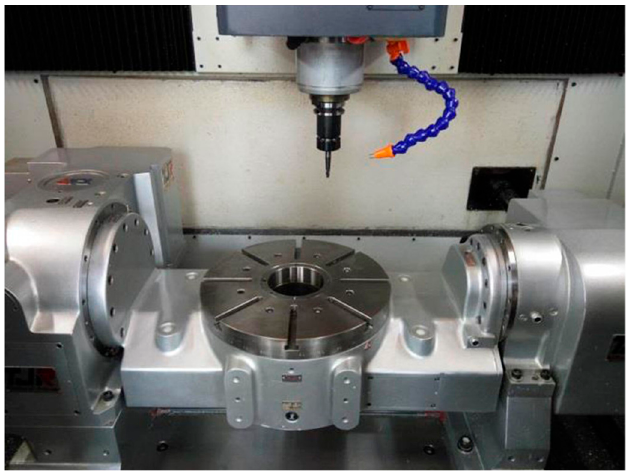
Table 1. Parameters of GSPSO algorithm.